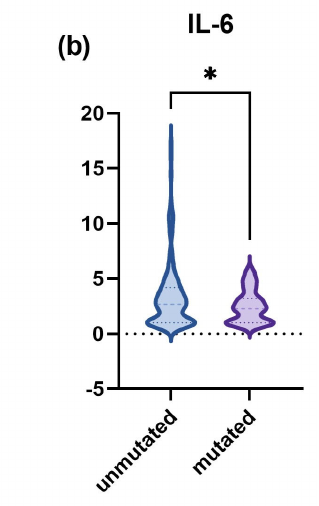
Figure 2. Comparison of IL ‐ 6 and TNF ‐α levels between p.R4810K mutated and unmutated in RNF213. ( a , b ) are the differences between the mutation group and the non ‐ mutation group when TNF ‐α and IL ‐ 6 were analyzed as continuous variables. ( c , d ) are the differences between the muta ‐ tion group and the non ‐ mutation group when TNF ‐α and IL ‐ 6 are divided into a high ‐ level group and a low ‐ level group for analysis. ns, no significance; * p < 0.05. 3.3. IL ‐ 6 and TNF ‐α Are Associated with Poor Functional Prognosis after Surgery for Adult MMD Inflammatory factors were analyzed in univariate regression along with other factors that may affect the prognosis of MMD. Univariate logistic regression analysis revealed that IL ‐ 6 and TNF ‐α subgroups were associated with an increased risk of poor functional outcome after surgery in adults with MMD. In the G3 subgroup of IL ‐ 6 and the G4 sub ‐ group of TNF ‐α , the risk of poor prognosis of MMD was higher than that of the G1 sub ‐ group. (OR 3.678, 95% CI [1.491, 9.074], p = 0.005; OR 2.996, 95% CI [1.180, 7.610], p = 0.021). Univariate logistic regression analysis showed that advanced age (OR 1.081, 95%CI [1.047, 1.116], p < 0.001) and hypertension (OR 2.631, 95%CI [1.435, 4.826], p < 0.05) Risk factors for poor functional outcome after MMD surgery. The specific univariate logistic regres ‐ sion analysis results are shown in Supplementary Table S3. Trend regression analysis showed that with the increase in TNF ‐α level in blood, the risk of poor prognosis in MMD patients gradually increased, with a significant trend (P